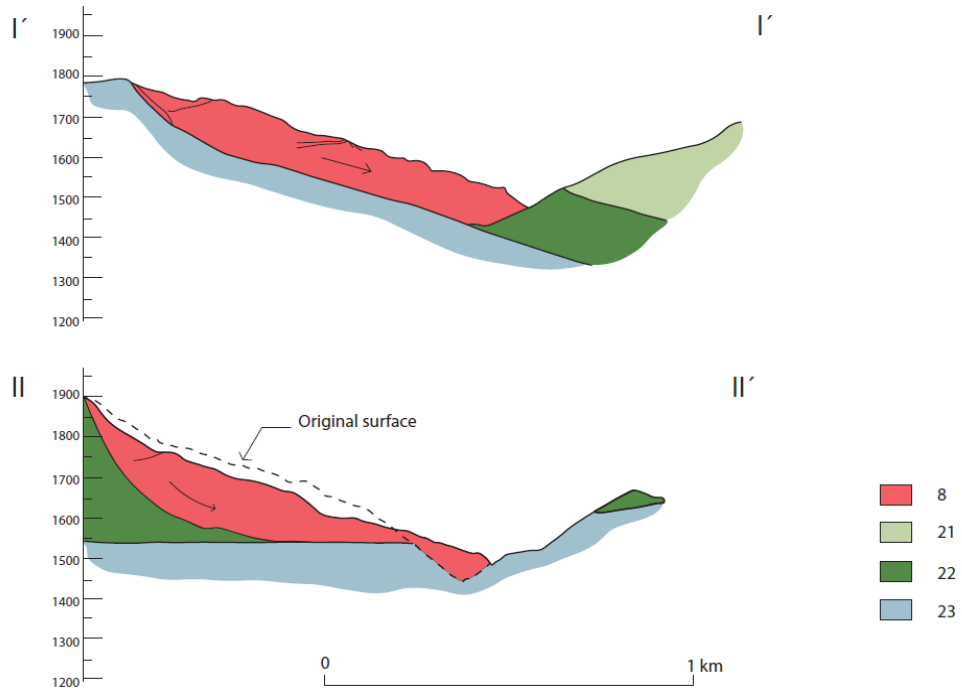
Figure 5. Geological sections ( I )-( I’ ) and ( II )-( II’ ) of Figure 4B. (8): Landslide deposit from (22); (21): sandstones and lutites; (22): lutites and clays; (23): limestones.